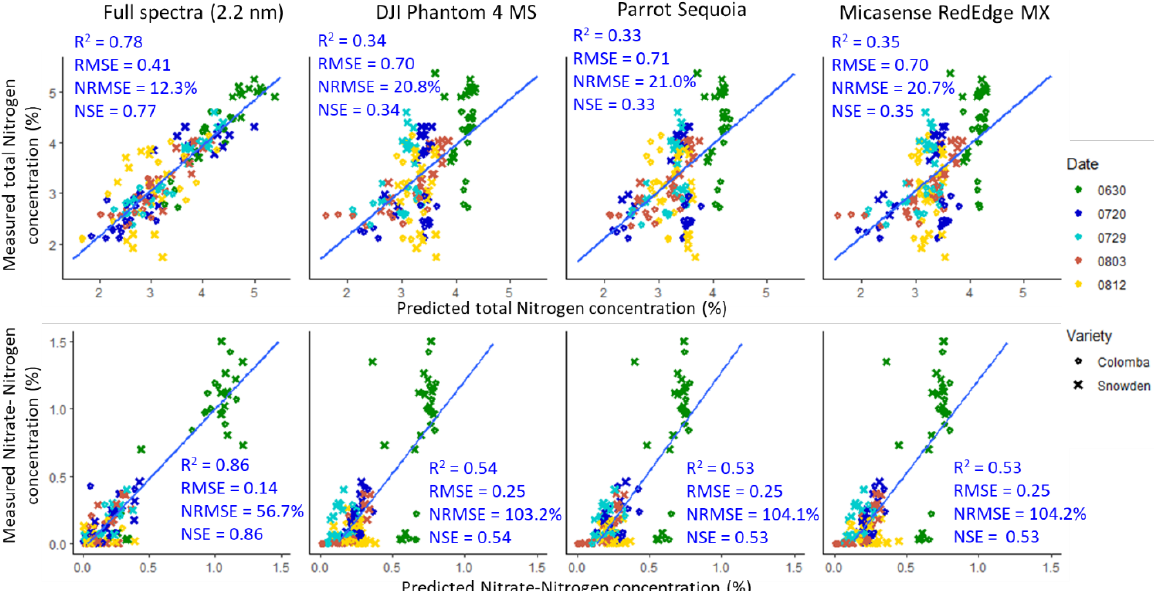
Figure 4. Scatterplots of the predicted and measured potato N concentrations. The predicted values were from PLSR models with the hyperspectral reflectance and synthesized reflectance of three popular multispectral cameras. The blue solid line in each plot represents the line of y = x . The Pearson correlation coefficients ( r ) between reflectance values and the ground data are shown in Figure 5a,b. Reflectance in the visible range (<750 nm) had stronger correlations with either of the two N status indicators than the NIR region. The highest correlations (| r | > 0.55) for the total N concentration were located at the wavelengths around 430–470, 570–590, and 650–700 nm within the visible range, corresponding to the blue, green, and red bands of the multispectral cameras, respectively (see detailed bands and values in Supplementary Tables S1 and S2), while wavelengths around 550–600 and 700 nm are highly correlated (| r | > 0.55) with the petiole nitrate-N concentration, corresponding to the green and red bands. Similar conclusions were found in [15,48] that spectral bands in the visible regions were highly correlated with the potato canopy N status and in [16,17] that the red-edge regions were good linear estimators of potato N concen- trations.